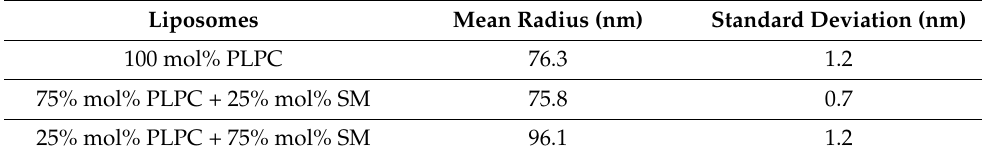
Table 1. Radius of PLPC liposomes with different SM molar fraction determined by